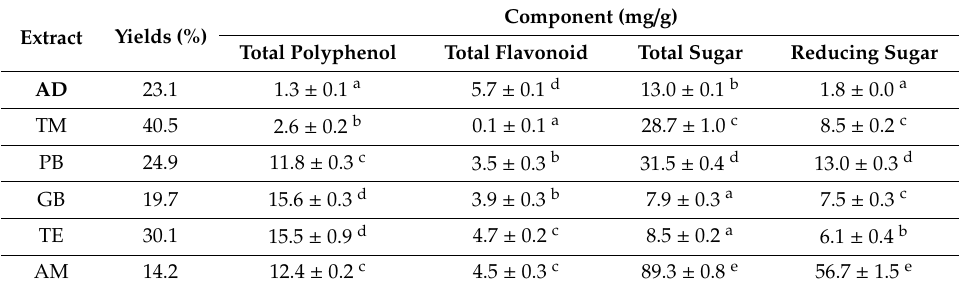
Table 2. Yields and component assay of the ethanol extracts of 6 di ff erent insect species. Extract Yields